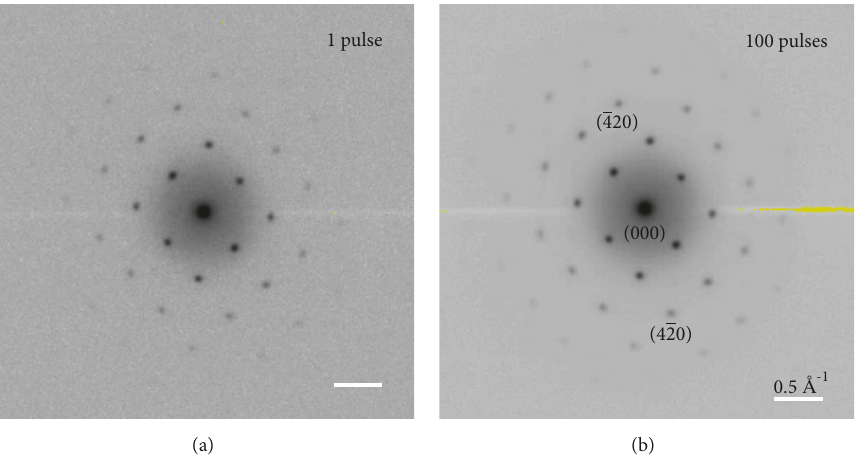
Figure 2: Relativistic diffraction images of 10 nm thick (100)-orientated single-crystalline gold film measured with (a) single-pulse (single- shot) and (b) 100-pulse integration. The energy of the femtosecond electron pulses was 3.1 MeV, and the number of electrons in each pulse was (6.3 ± 0.6) × 10 6